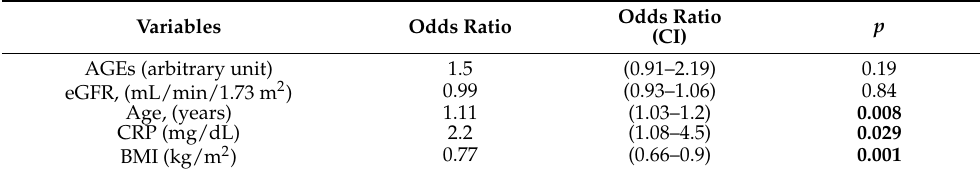
Table 4. Multivariate analysis of the relationship between AGEs, eGFR, age, CRP, BMI, and sarcopenia.